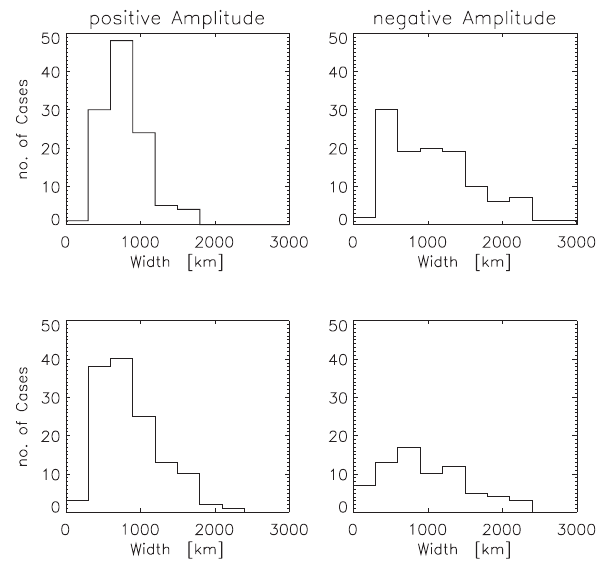
Fig. 4. Distribution of the maxima (left column) and minima (right column) as a function of geomagnetic latitude for the Northern (up- per row) and Southern (lower row) Hemisphere.